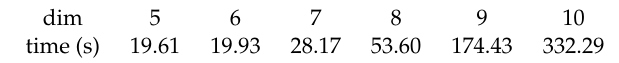
Table 1. Generation times of 100,000 Gray Codes (GCs) in function of the dimension of the N -cube. dim